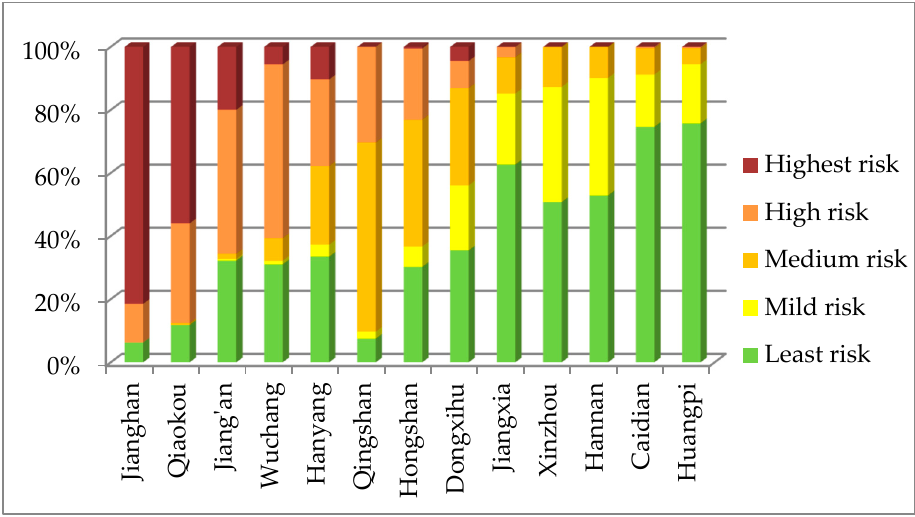
Figure 9. Area proportion of various flood risk levels of 13 districts in Wuhan in 2018.